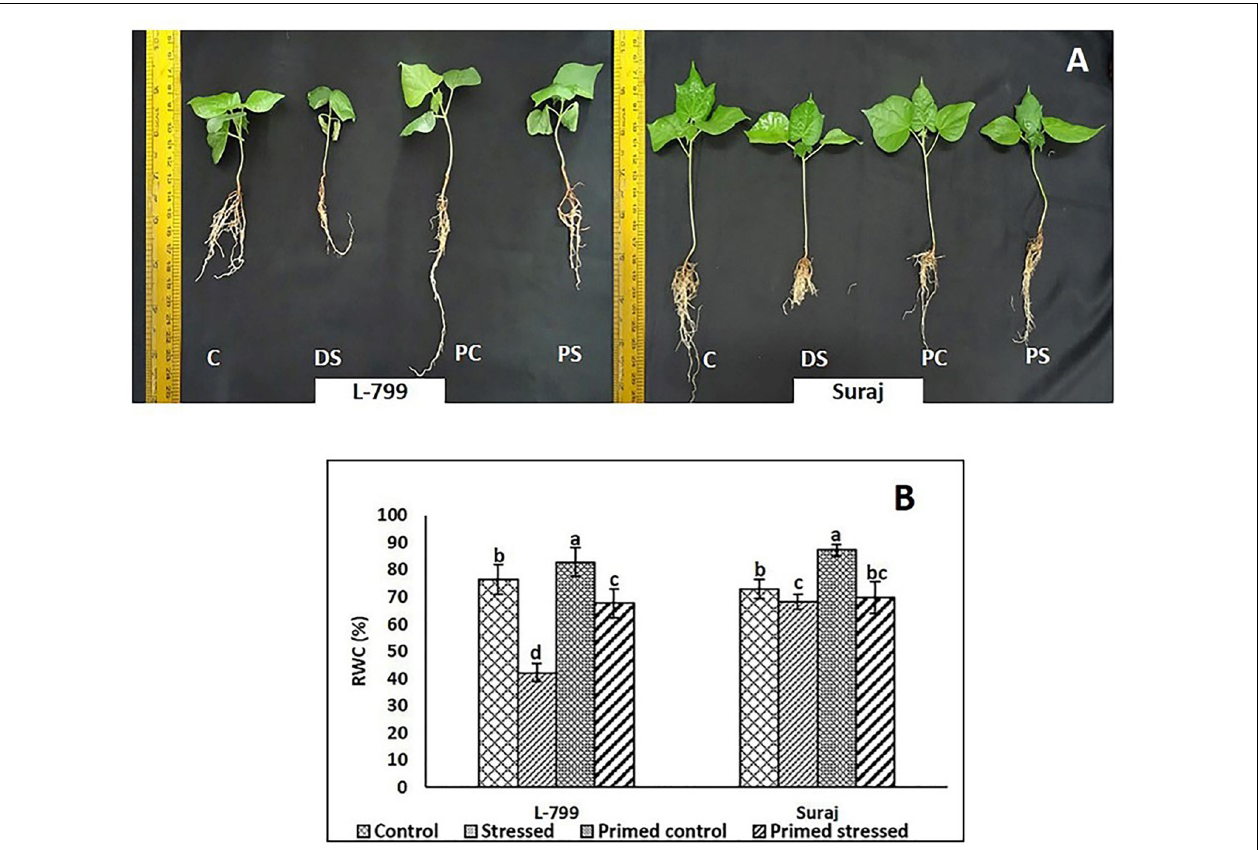
FIGURE 1 | Phenotypic changes in melatonin primed and unprimed plants of drought-sensitive (L-799) and -tolerant (Suraj) varieties of cotton ( Gossypium hirsutum ) under optimal or drought-stress conditions. (A) C, Plants grown under optimal conditions (control). DS, Plants grown by withholding water for 8 days (drought-stressed). PC, Melatonin primed plants grown under optimal conditions (primed control). PS, Melatonin primed plants grown by withholding water for 8 days (primed stress), and (B) Relative water content (%) in leaves of L-799 and Suraj under drought stress with and without melatonin priming. Data represent mean values ± SD of 3 independent experiments, with 3 replicates per treatment in each experiment. Different alphabets within the group represent significant differences among the treatments according to Duncan multiple range test at P <